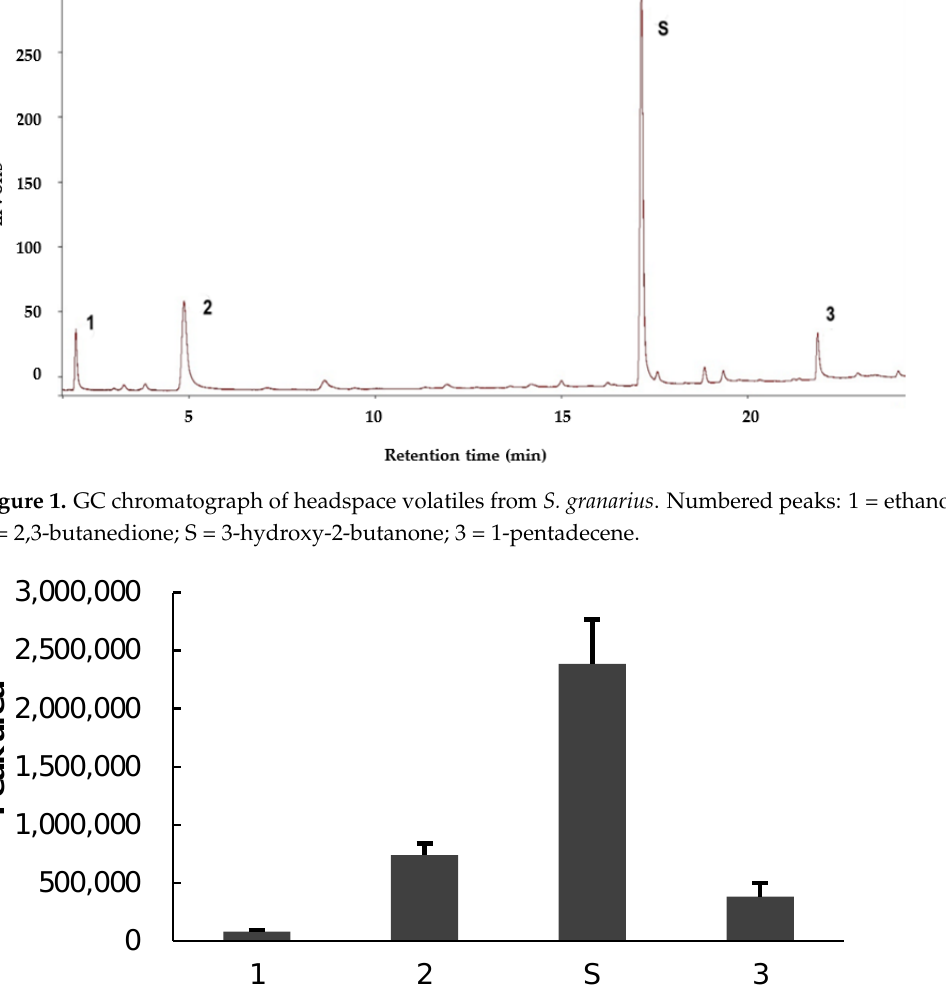
2 = 2,3-butanedione; S = 3-hydroxy-2-butanone; 3 = 1-pentadecene.